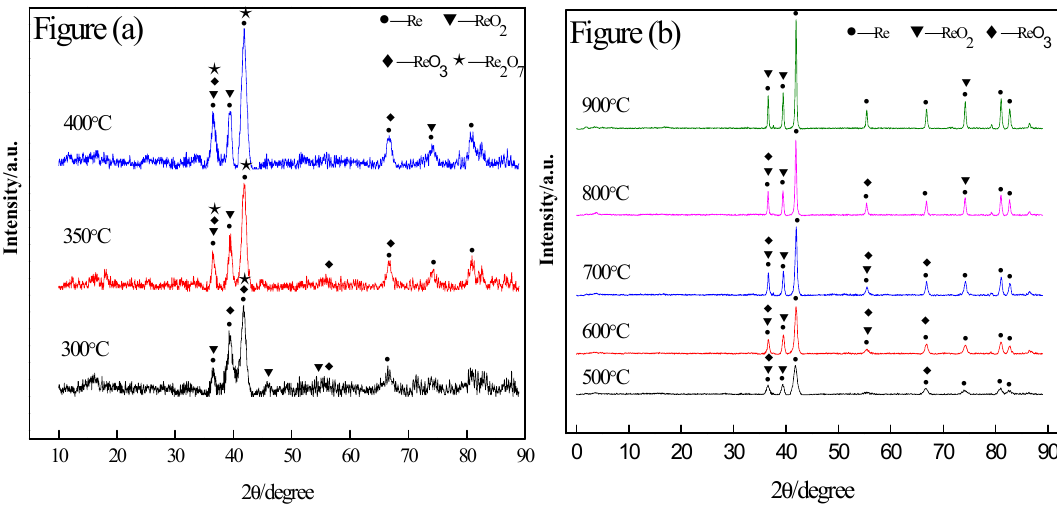
Figure 7. XRD patterns of the reduction products of ammonium perrhenate (D 50 was 81.05 µm, specific surface was 21.72 m 2 /kg) at different temperatures. Figure ( a ) was the XRD diffraction pattern of the reduced product at 300 to 400 °C; Figure ( b ) was the XRD diffraction pattern of the reduced product at 500 to 900 °C.